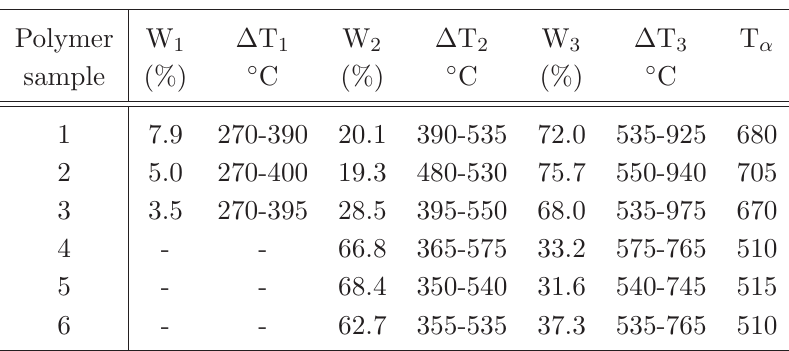
Table 2 Thermogravimetric characteristics of the synthesized